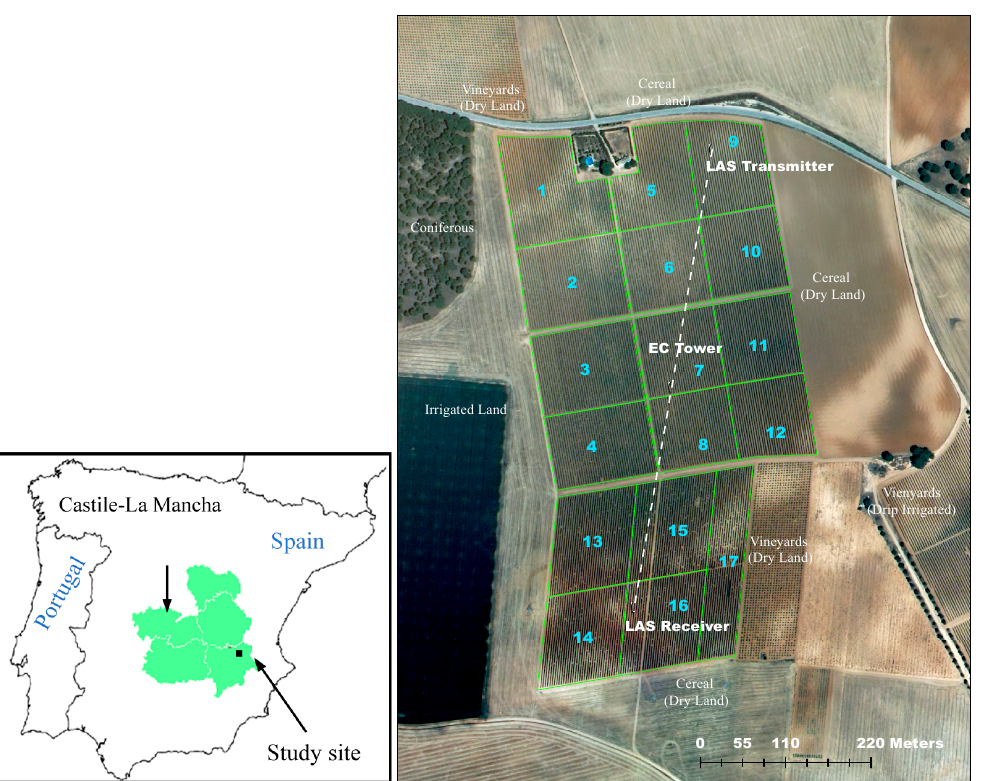
Figure 1. Aerial photograph of the study site with the 17 drip-irrigated vineyard fields, along with the location of the large aperture scintillometer (LAS) transmitter and receiver and eddy covariance (EC) tower. The numbers inside each polygon represent the field numbers. The LAS transmitter was located in Field 9 and the receiver was located in Field 16. The EC tower was located within Field 7 along the LAS path. The spaces between Fields 2 and 3, as well as other similar ones (~5–10 m), were for field accessibility purposes.